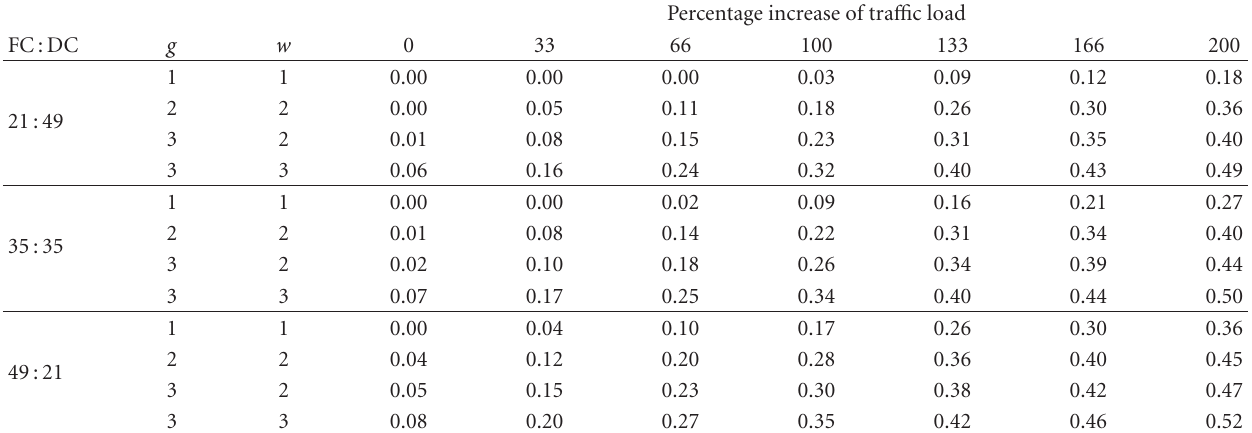
Table 1: Blocking probabilities with no reassignment.